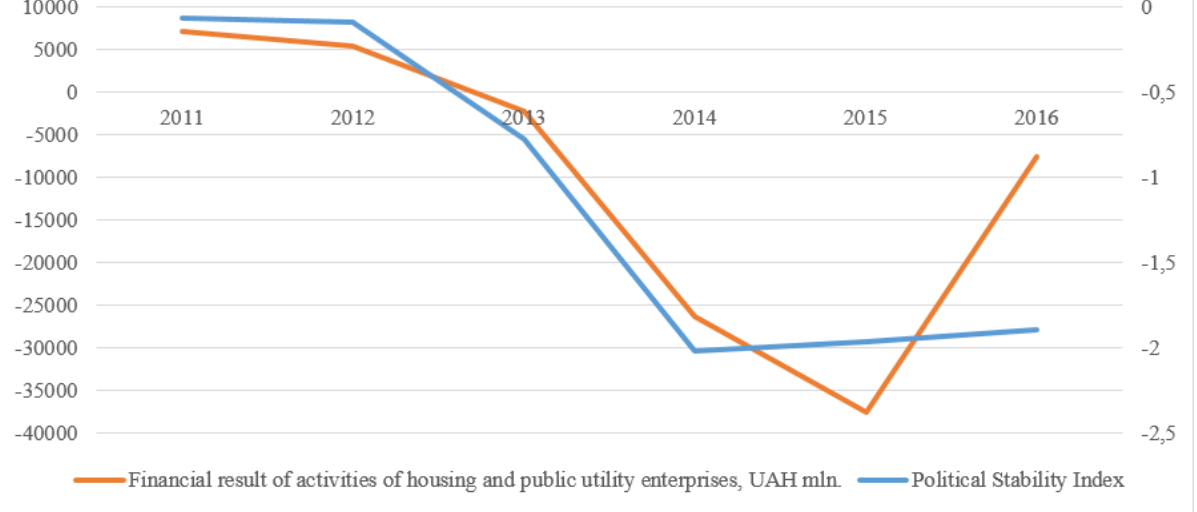
Figure 2. Growth of the index of political stability of Ukraine and financial result of housing and utility enterprises activity in the period 2011−2016